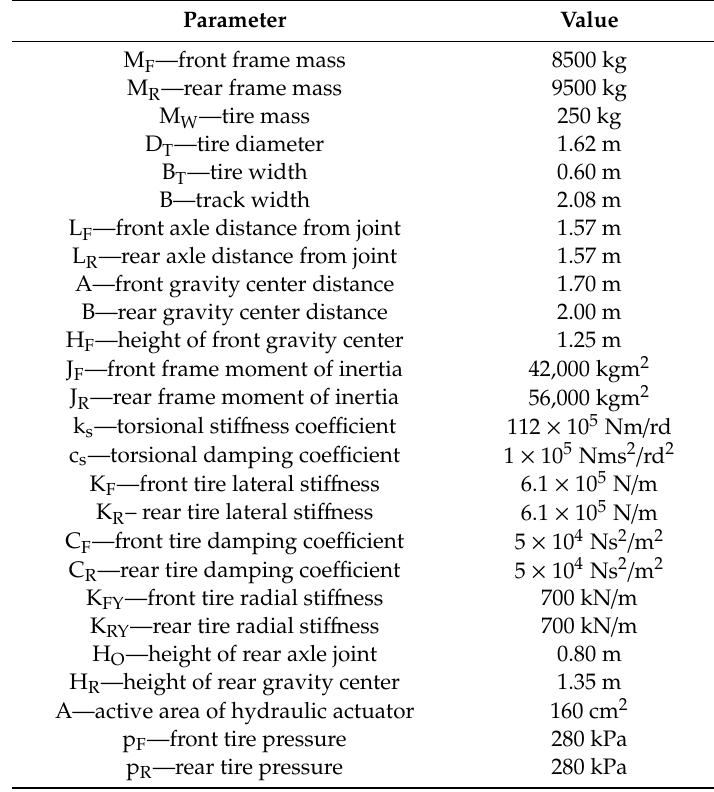
Figure 7. Assumption for model of the articulated vehicle as a steered vehicle. Table 1. Parameters of the Articulated Vehicle Model.